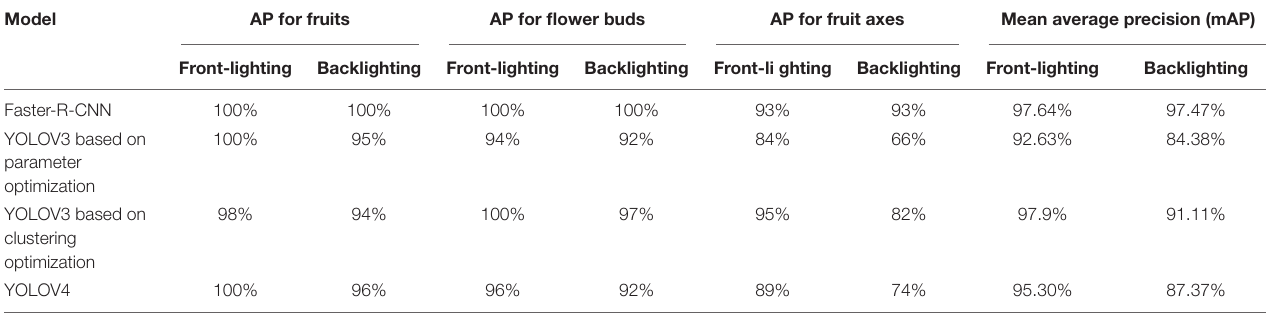
TABLE 3 | Comparison of the multi-target detection results between the YOLOv3 model, YOLOv3 model based on clustering optimization, R-CNN model and YOLOv4 under front-lighting and backlighting conditions. Model